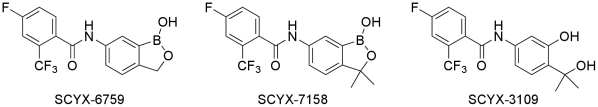
Chemical structures of compounds.